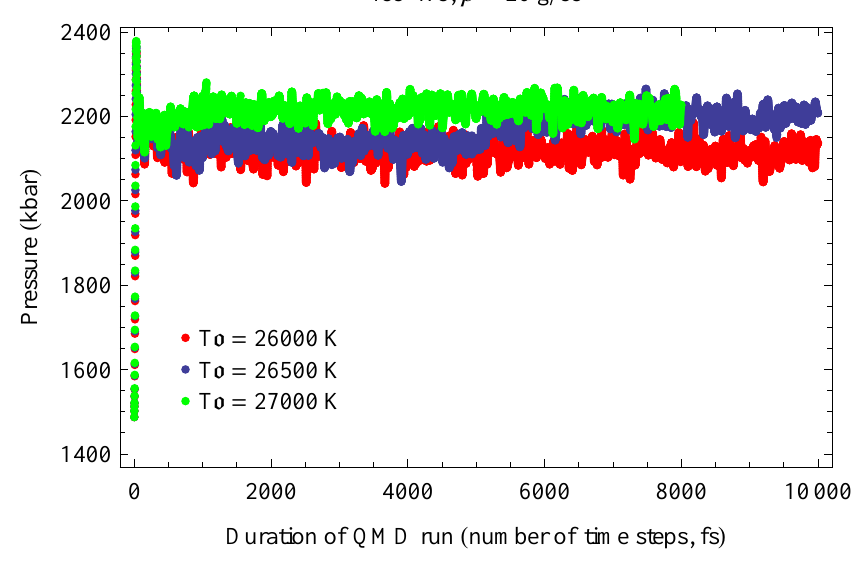
Figure 7. The same as in Figure 4 for fcc-Re. Figure 10. The same as in Fig. 8 for fcc-Re.